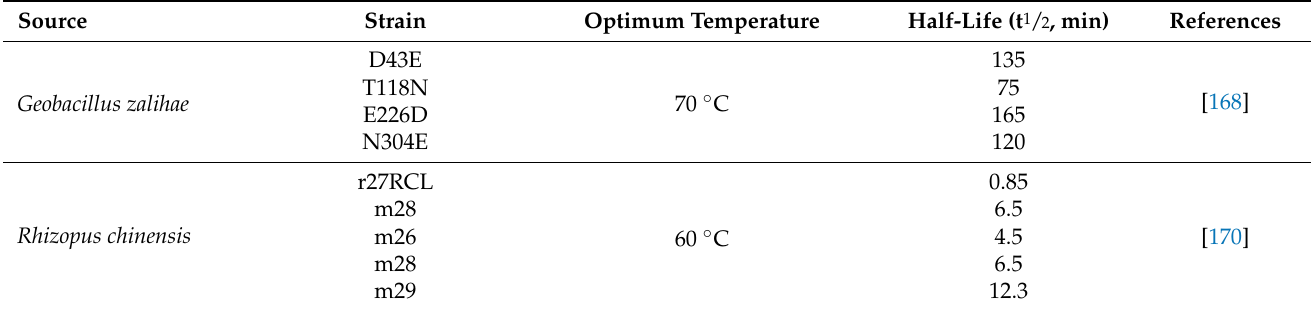
Table 4. Optimum temperature and half-life of microbial